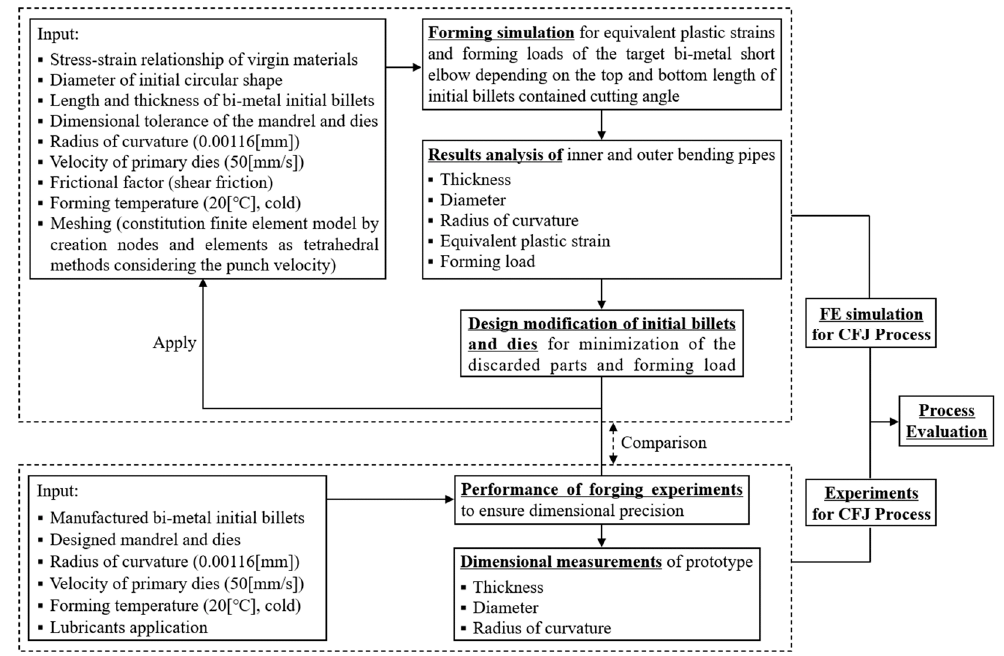
Figure 1. Design procedures for CFJP evaluation.